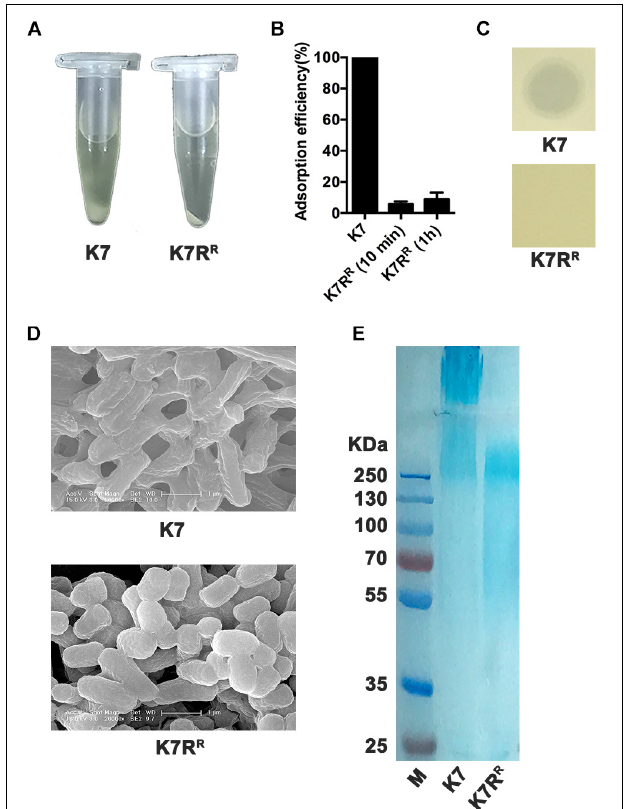
FIGURE 1 | Characteristics of K. pneumoniae K7 and K7R R . (A) Centrifugation analysis of K. pneumoniae K7 and K7R R . The cultures were centrifuged at 10,000 × g for 5 min at 4 ◦ C. (B) Adsorption efficiency of GH-K3 binding to K. pneumoniae K7 and K7R R . Data represent the mean ± SEM of triplicate experiments. (C) Spot assays for GH-K3 on K. pneumoniae K7 and K7R R . Five µ l of phage solutions were spotted onto freshly lawns of K. pneumoniae K7 and K7R R for 6 h at 37 ◦ C before observation. (D) SEM analyses of the surface morphology of K. pneumoniae K7 and K7R R .